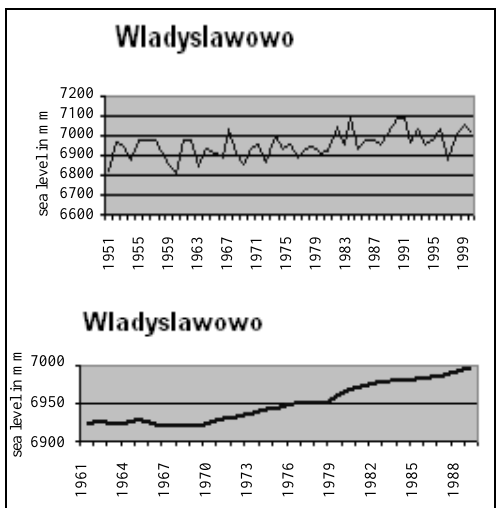
Fig 6. Tide gauge data before (up) and after smoothing (down) One is the slope of line b indicating the speed of changes and the initial value a for those changes.